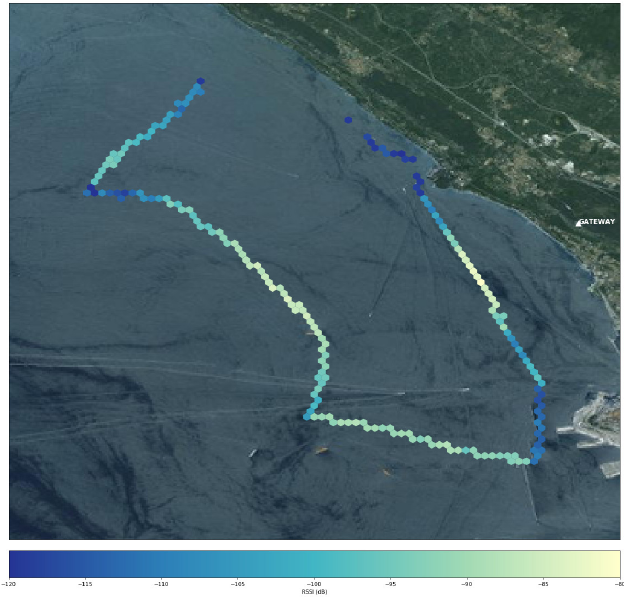
Figure 4. Coverage of the gateway located at Monte Grisa